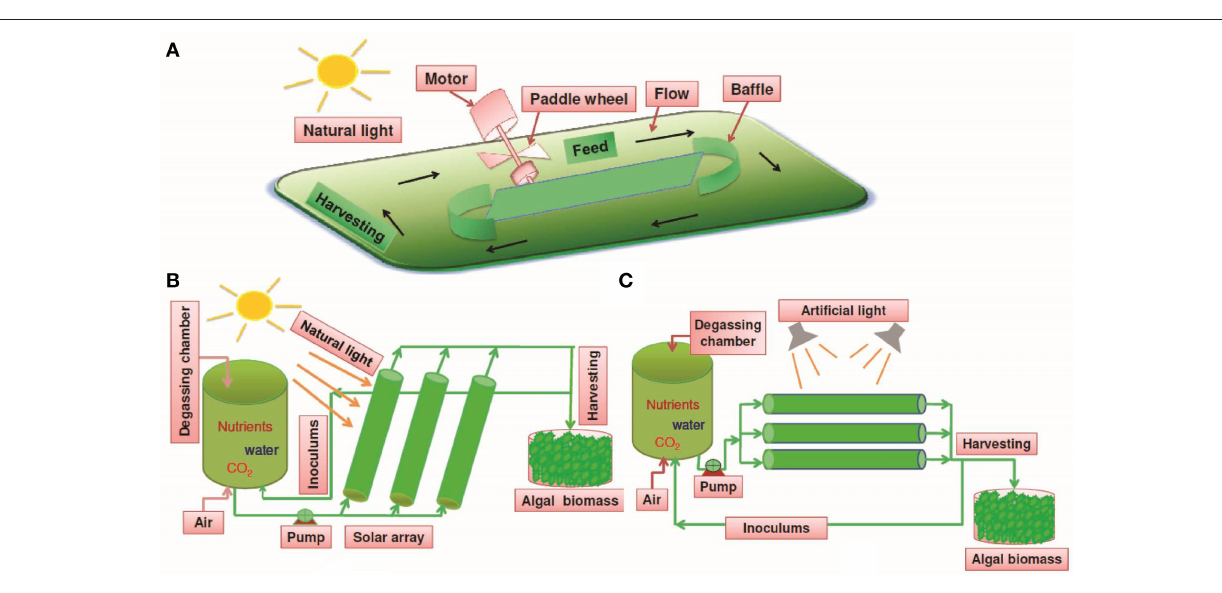
FIGURE 3 | Different cultivation systems for large-scale production of algal biomass. (A) Open raceway pond system using natural solar light as a source of energy; (B) Closed system using natural solar light as a source of energy; (C) Closed system using artificial light as a source of